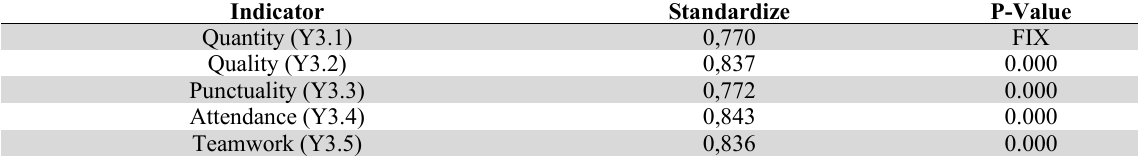
Results of Performance Measurement Model Examination (Y3)